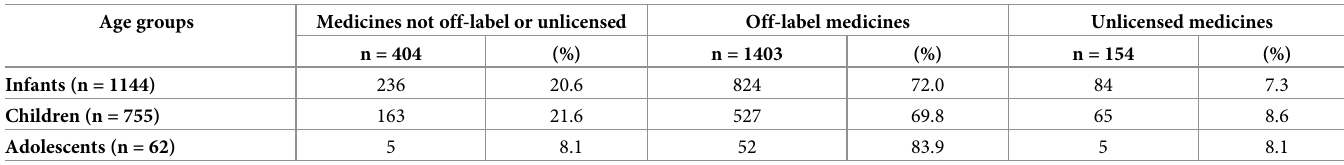
Reasons for off-label and unlicensed prescribing Of the 1403 drugs which were prescribed ‘off-label’, the most common reason given was indi- cation (diagnosis) (n = 810; 57.7%), followed by age/weight (n = 655; 46.7%), dose/frequency (n = 579; 41.3%) and the use of contraindicated drugs or those with special precautions or not recommended to be used in the patient age prescribed (n = 294; 21.0%). No drug was off-label for route of administration. Neither length of stay (2–3 days vs 4–6 days, p = 0.063; 7+ days vs 4–6 days, p = 0.11) nor gender (p = 0.92) were associated with the rate of off-label prescribing. The GEE model shows several factors that were independently associated with off-label pre- scribing (Table 5). While age group appeared to be significantly associated with off-label pre- scribing based on univariate analysis (Infants: 77.7%; Children: 76.4%; Adolescents: 91.2%; with the p-value for Adolescents vs others p = 0.01), this difference did not persist after adjust- ment for the other independent variables in the model. As there were no neonates admitted to this ward, it was not possible to determine if off-label prescribing would have been more or less frequent in this age group. Other independent variables in the GEE model were dropped as they appeared to be not significantly associated with the outcome (including gender, body weight, length of hospital stay, ATC drug category and diagnoses). The p-values for the variables which were dropped were: gender (p = 0.92), weight (0.20). We divided LOS into short (2–3 days), medium (4–6 days), and long (7+ days). With medium stay as the reference, the p-value for short was p = 0.063, and for long stay it was p = 0.11, and therefore it was also dropped from the final model. ATC categories and diagnoses which were not included in the final model were dropped because they showed no significant association. It is notable that an indication of tuberculosis was associated with lower off-label prescribing (p = 0.0037), and malaria was asso- ciated with a higher rate (p = 0.0004). The specific ATC codes also influenced off-label Table 4. Frequency of off-label and unlicensed prescribing based on total drugs prescribed. Age